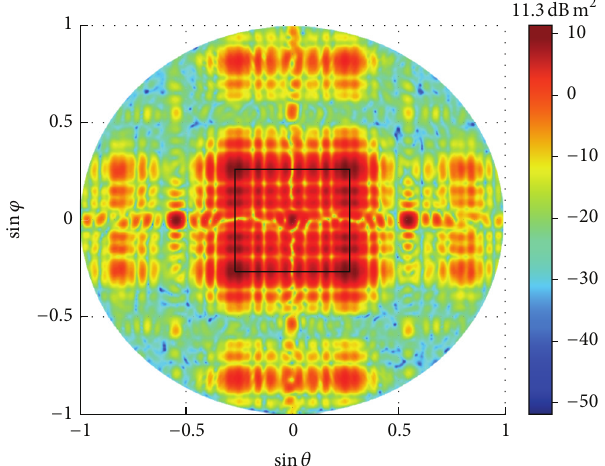
Figure 13: Contour plot of bistatic RCS pattern for optimized phase layout at 17 GHz. Black frame represents the main period.